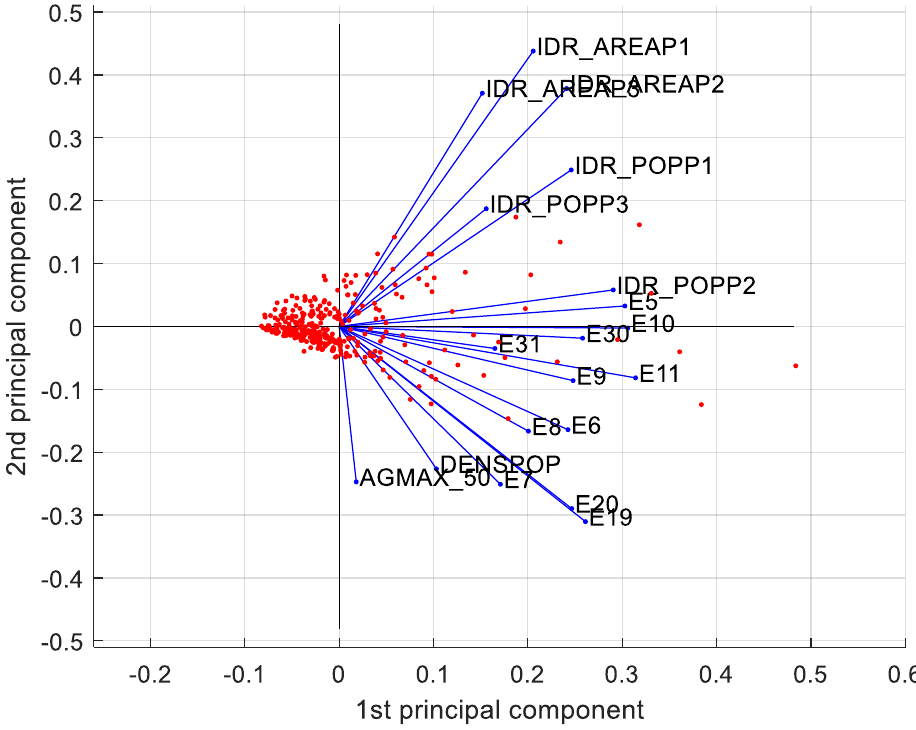
Figure 8. Biplot along the first two principal